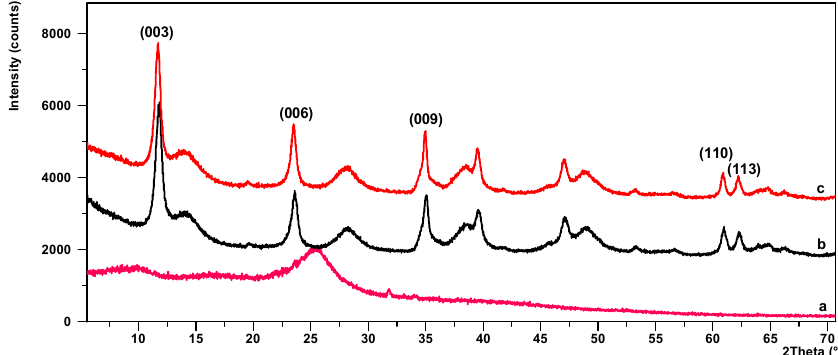
Figure 4. Powder diffraction patterns for CA ( a ), LH ( b ), and LH/CA (20%) ( c ).